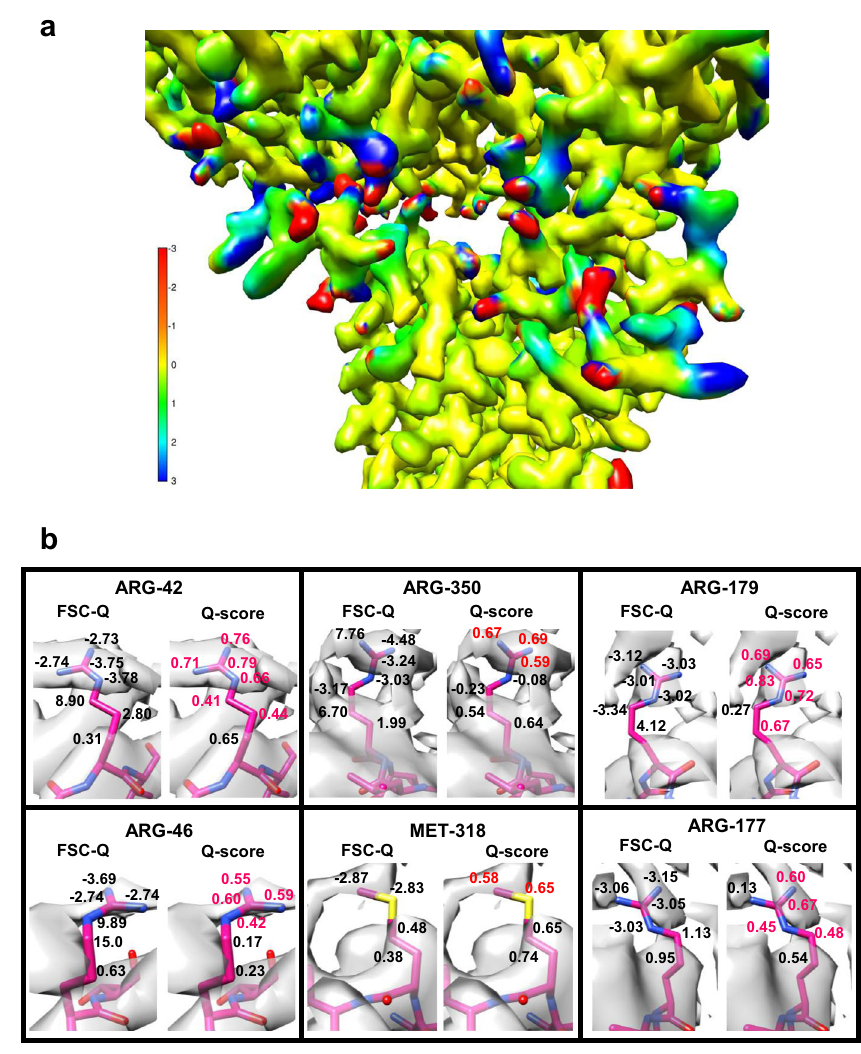
Fig. 4 FSC- Q for a fragment of the PAC1 GPCR receptor complex (EMD-20278). a FSC- Q values superimposed on the map generated from the atomic model (pdb id: 6p9y). Red areas indicate side chains that fi t into densities of the detergent micelle. Blue areas correspond to atoms with very low resolvability. b FSC- Q and Q -scores values are shown on each side chain atom of some residues that fi t to the detergent (ARG-42 chain B, ARG-350 chain R, ARG-179 chain R, MET-318 chain R, GLU-58 chain G, and ARG-177 chain